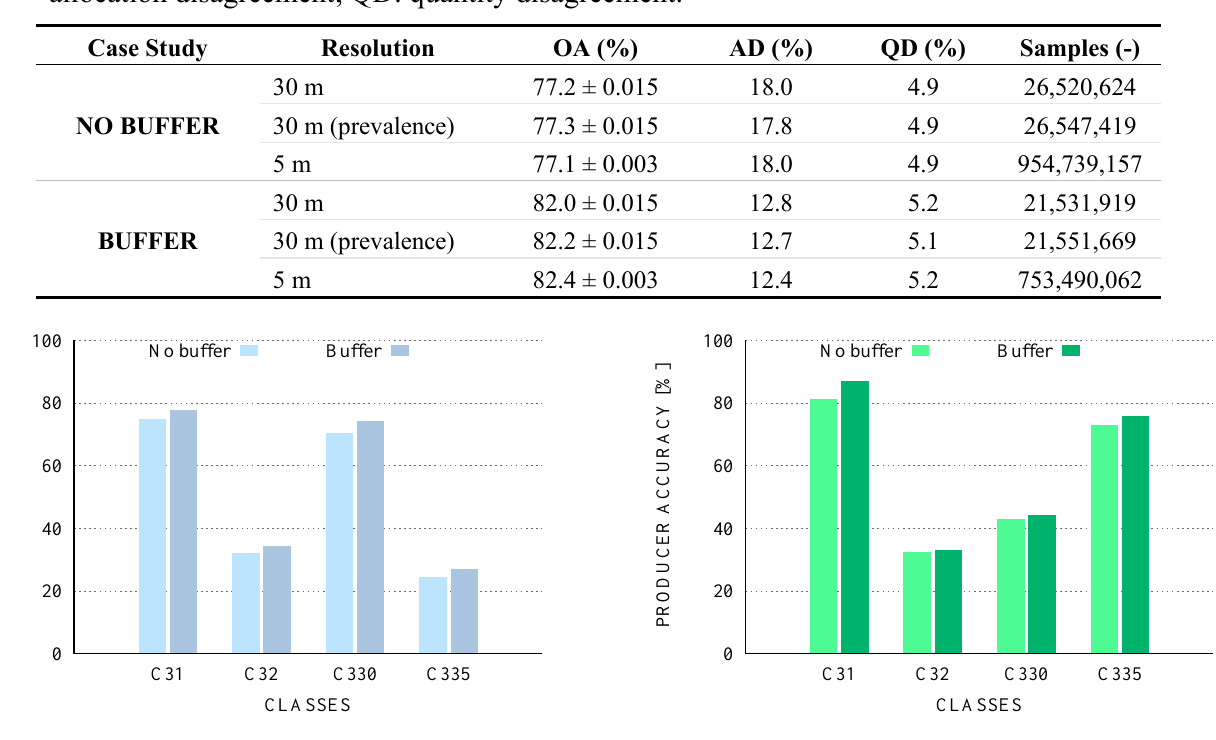
Table 6. Comparison between GlobeLand30 2000 and DUSAF1.1 (II reclassification): overall statistics and number of samples for the two cases of no buffer and buffer and for different resolutions. OA: overall accuracy (confidence intervals at 95% probability); AD: allocation disagreement; QD: quantity disagreement.